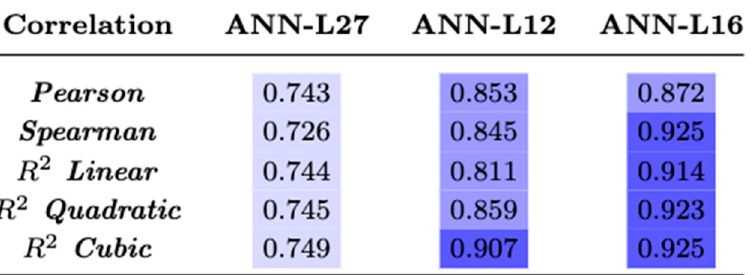
Figure 6. Correlation coefficients—ANN-L.